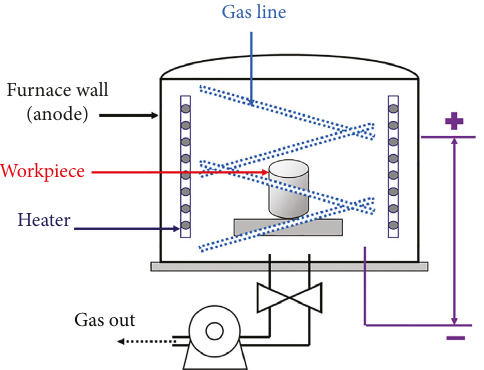
Figure 9: Schematic of the ion-nitriding equipment.